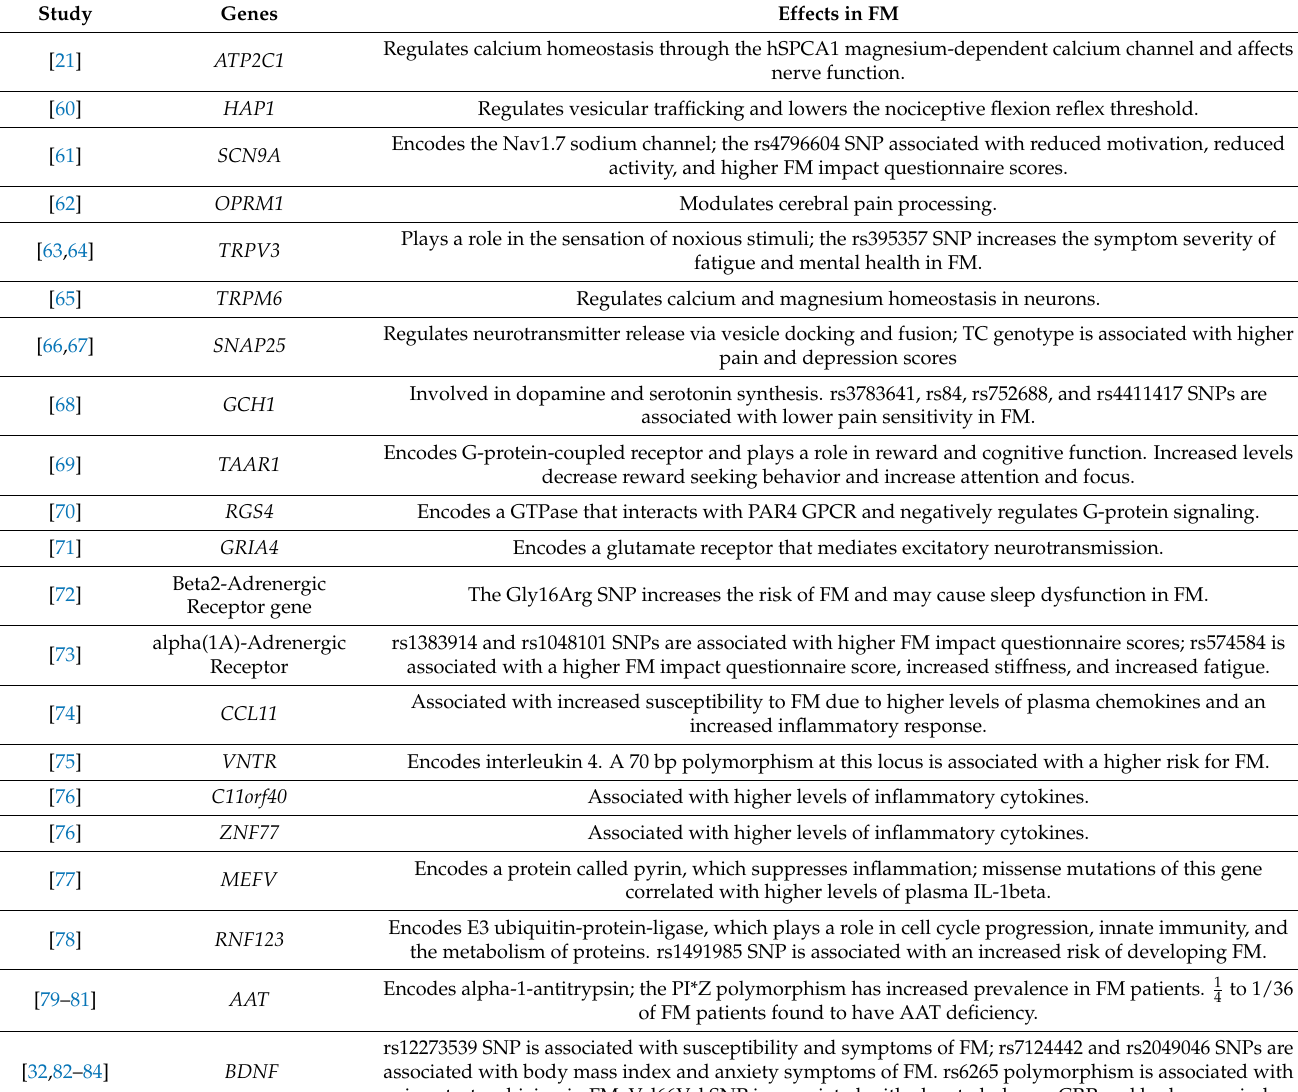
Table 3. Associations between Polymorphisms in Pain Pathway Processing Genes, Inflammatory Genes, Mitochondrial DNA, and Vascular Genes and the Development of